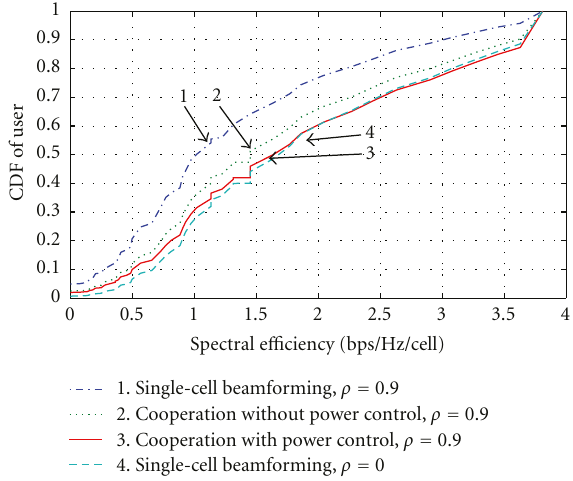
Figure 8: CDF of Spectral E ffi ciency with ρ = 0 . 9 and UEs employing two antenna